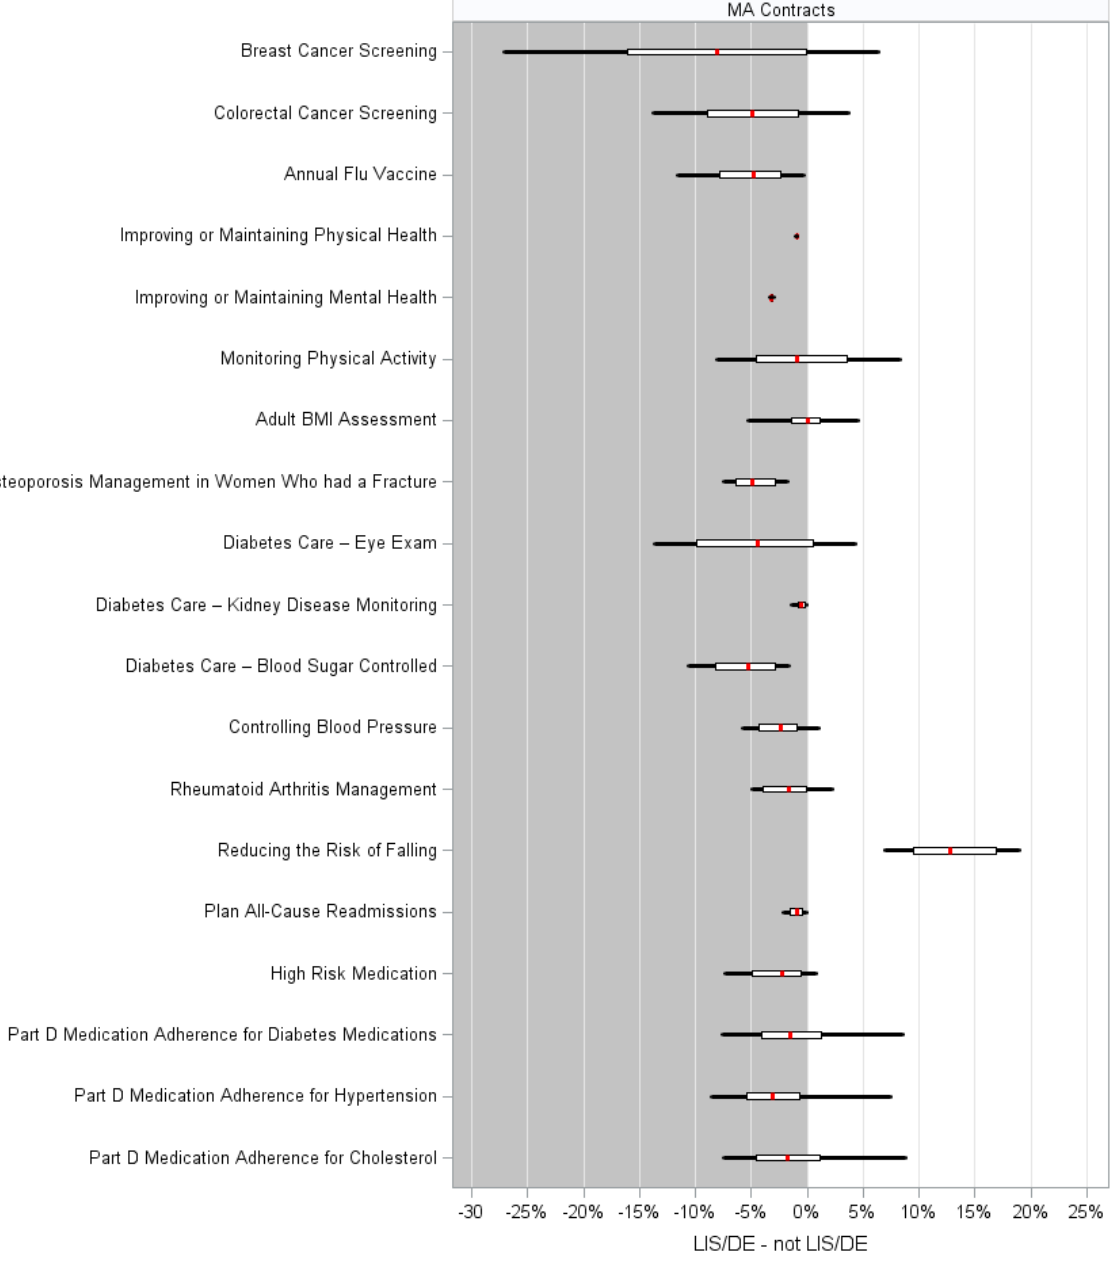
Figure 8.1: Variability of Effect of Dually-enrolled/LIS Status,